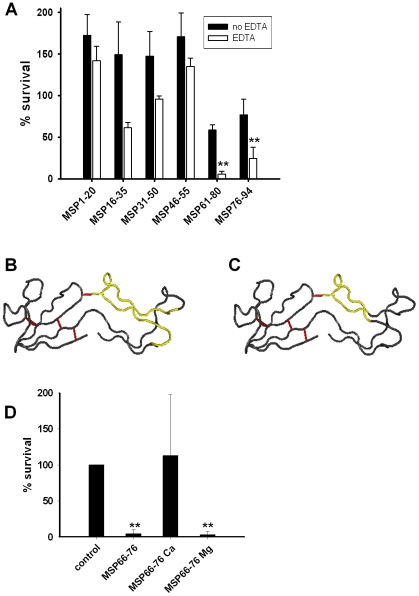
Antifungal activity of MSP-derived peptides.
A. Six overlapping peptides of 19–20 residues encompassing the entire MSP sequence (in a concentration of 5 µM) were tested in CFU assays at pH 4 against C. albicans with (white bars) or without EDTA (black bars). MSP61–80 displayed the most prominent fungicidal activity. Results are shown as the average from three independent experiments. B. Solution structure of MSP according to Ghasriani, et al [10] with MSP61–80 shown in yellow. Disulfide bridges are shown in red. C. Solution structure of MSP according to Ghasriani, et al [10] with MSP66–76 shown in yellow. Disulfide bridges are shown in red. D. MSP66–76 (140 µM) was tested in a CFU assay at pH 4. The fungicidal activity was inhibited by 0.5 mM calcium chloride but not 0.5 mM magnesium chloride. All results are shown as the average from three independent experiments. ** denotes p<0.001. Error bars indicate standard deviations. Further details regarding the statistical analysis are found in Dataset S1.